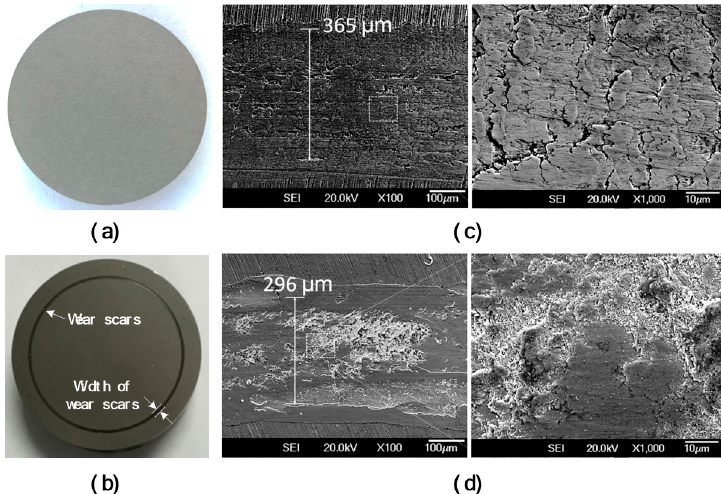
Figure 7. State of the specimen after wear testing: ( a ) State of the specimen before the abrasion test; ( b ) State of wear traces upon which a wear track occurred on the surface of the specimen due to the mechanical action between the ball surface and the specimen; ( c ) SEM images of the wear track before heat treatment of the HWS AM specimen; ( d ) SEM images of the wear track after heat treatment of the HWS AM specimen.